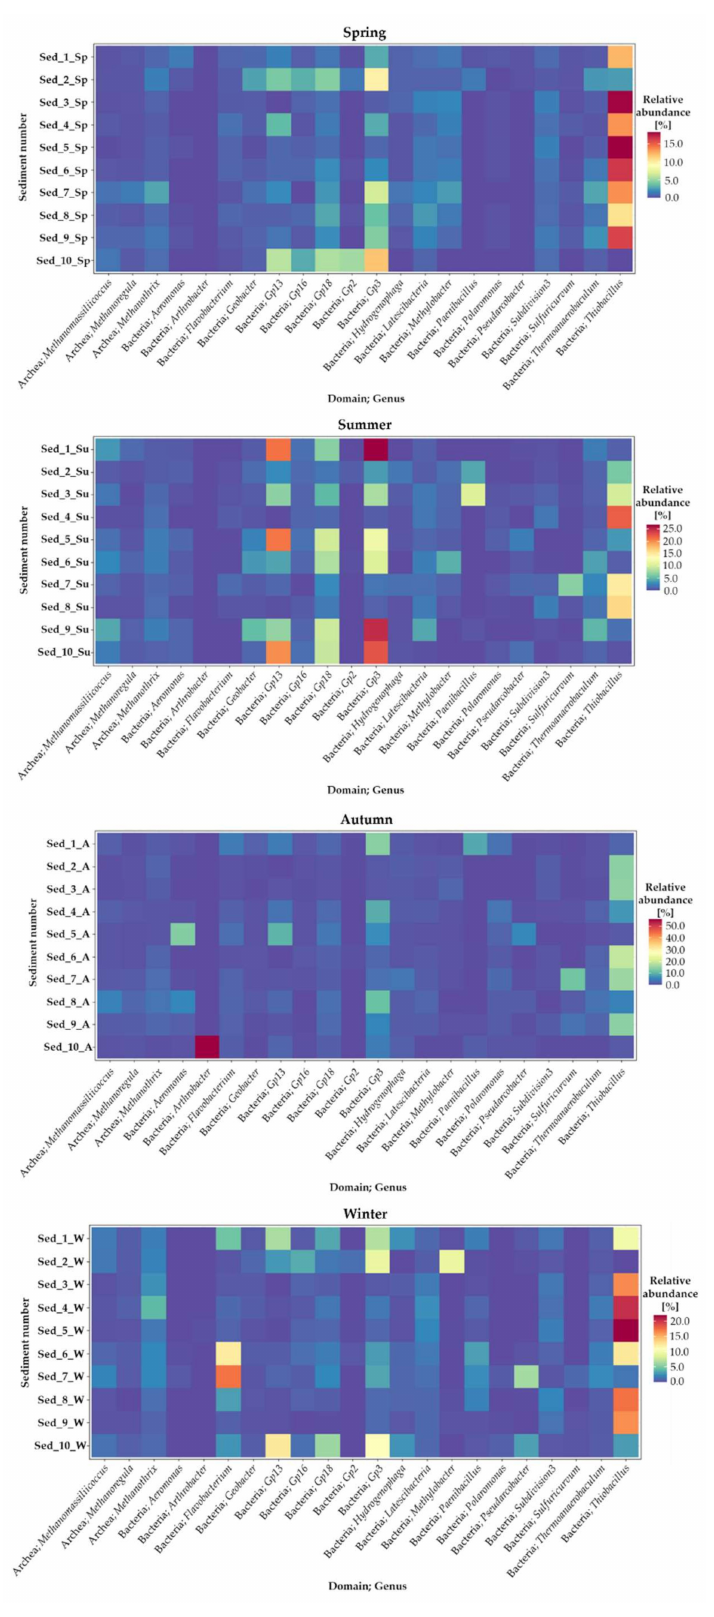
Figure 5. Heat map illustrating seasonal changes in the genera of bacteria in the selected locations of bottom sediments in Cardinal Pond (1–10 Sed—sediment sampling points; Sp—spring, Su—summer, A—autumn,